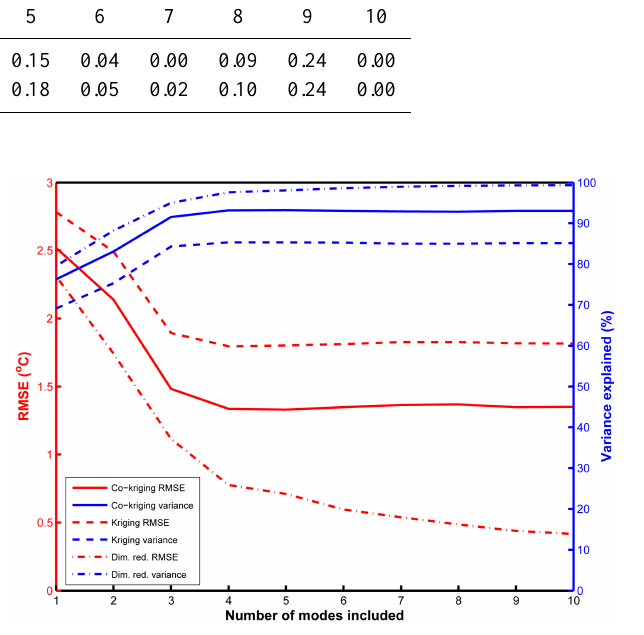
Figure 7. Comparison between kriging (dashed line) and co- kriging (solid line) emulators. The variance explained (blue) when each PC is added is shown together with the RMSE (red) of the corresponding reconstructed validation SAT fields. The dot-dashed lines represents the same values obtained if the emulator were per- fect. The deviations of these line from RMSE = 0 ◦ C and V = 100% are errors introduced by dimensional